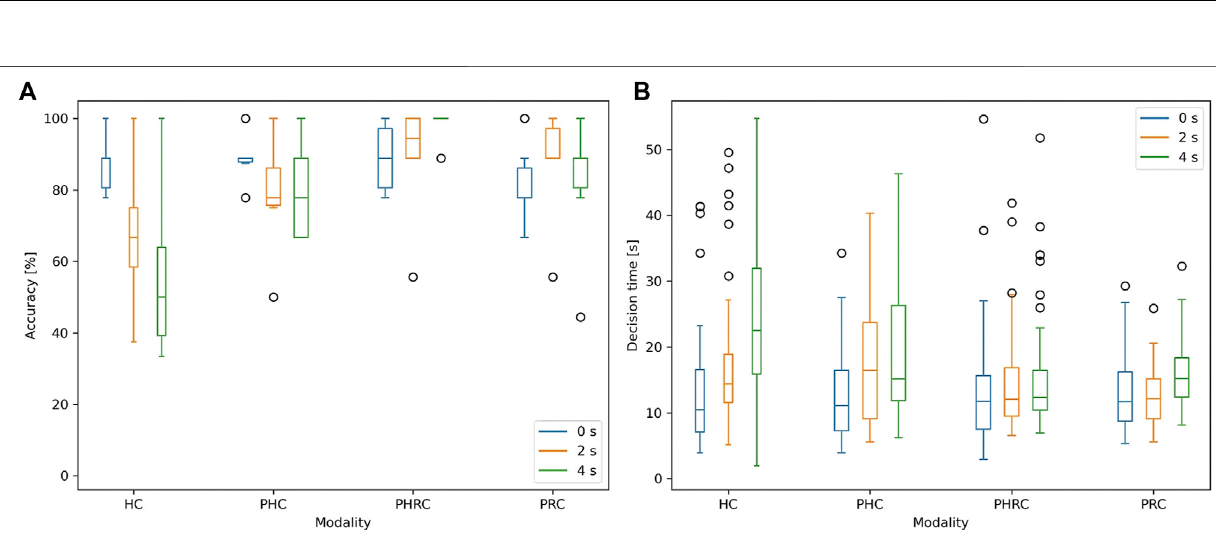
Frontiers in Robotics and AI |